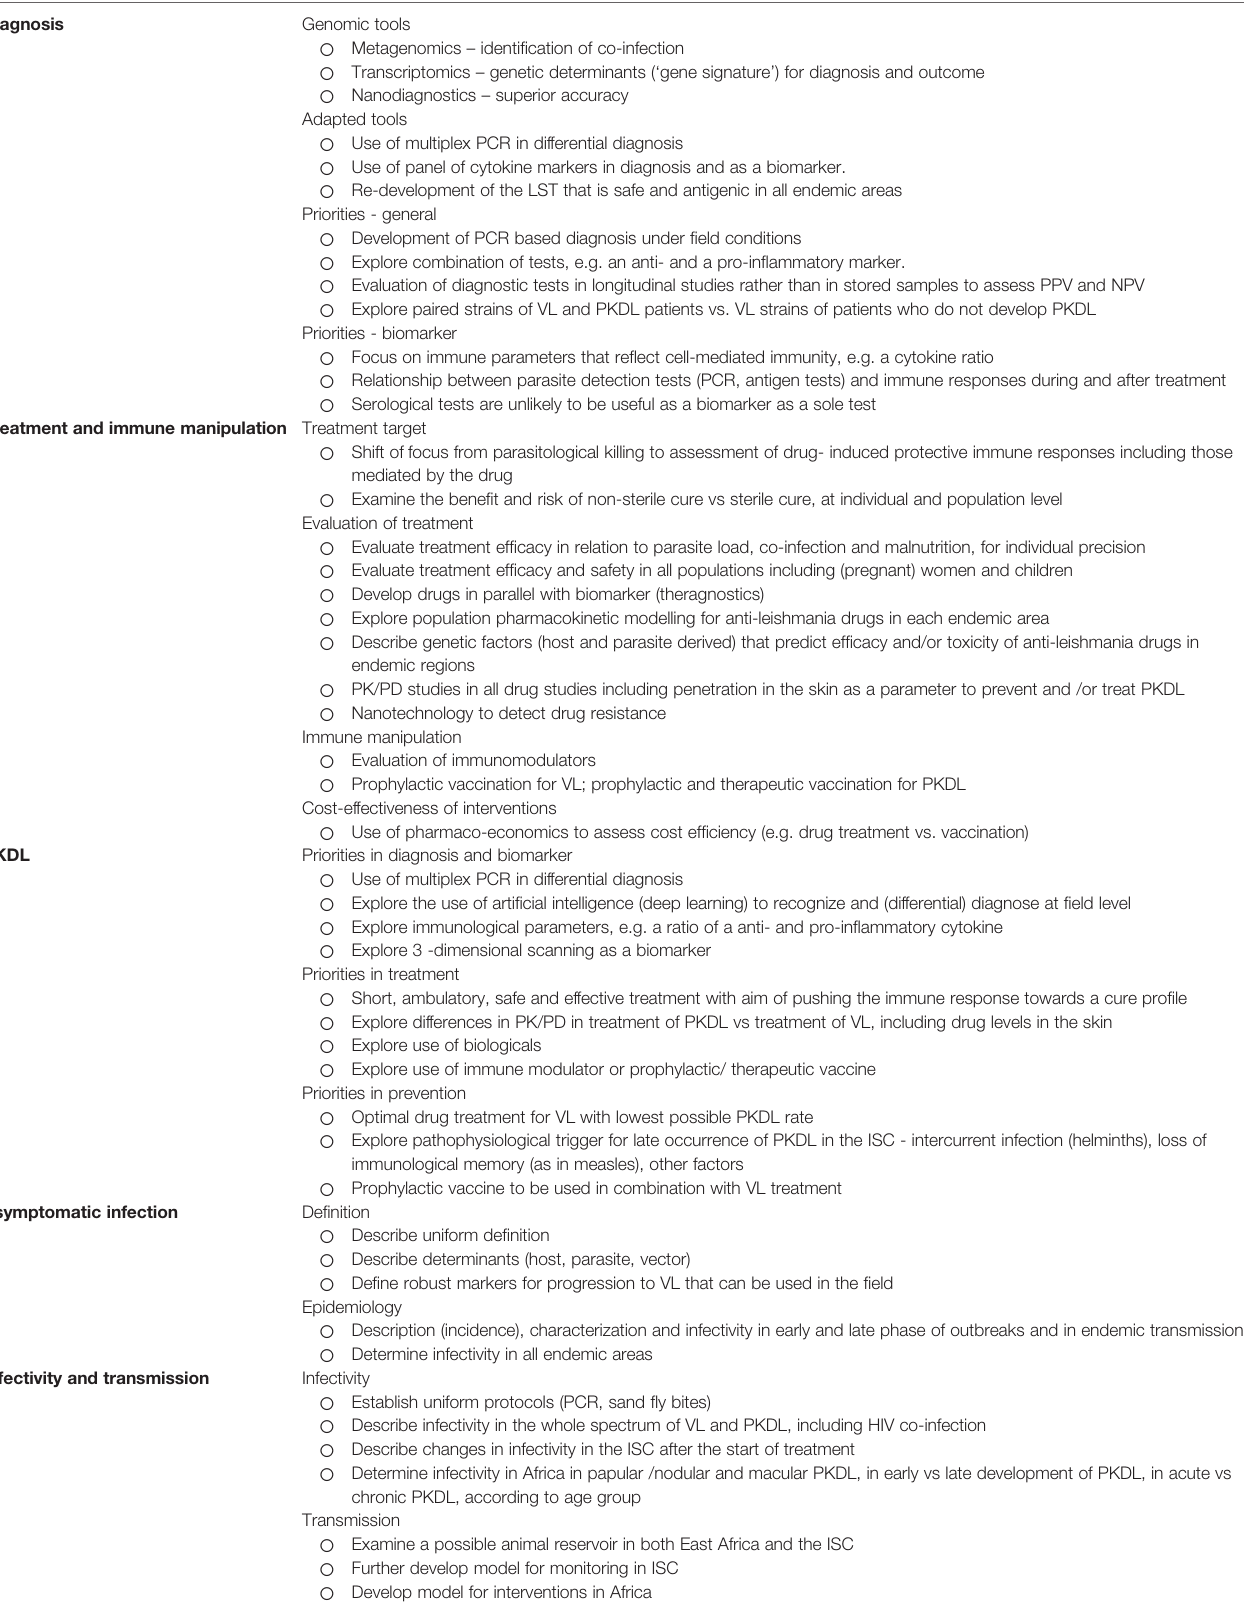
TABLE 1 | Priorities for precision in VL and PKDL research.